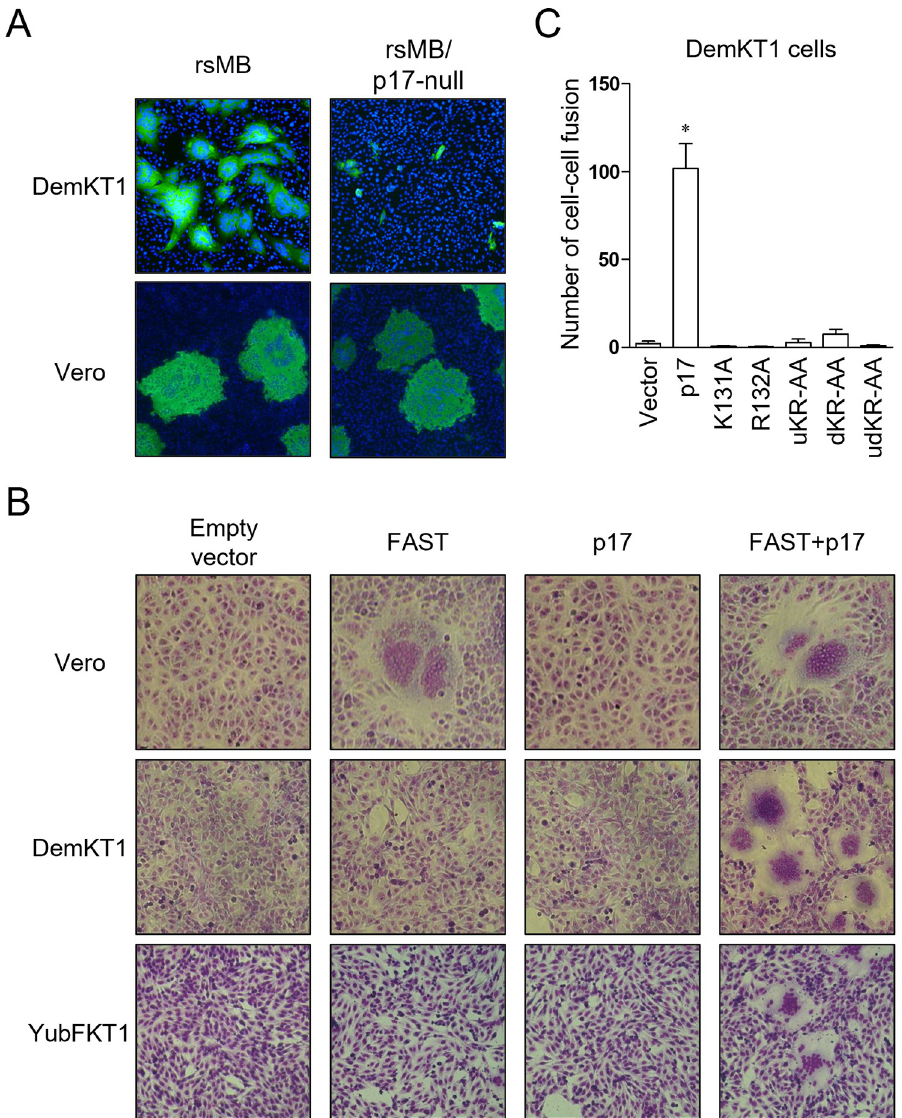
Fig 7. Cell–cell fusion activity of FAST is enhanced in the presence of p17 in bat cells. (A) Immunostaining of DemKT1 and Vero cells infected with rsMB or rsMB/p17-null at an MOI of 0.1 PFU/cell. Infected cells were stained using DAPI (blue) and an anti-NBV σ C antibody (green) to observe cell–cell fusion. (B) Observation of cell–cell fusion activity. NBV p17 and/or FAST expression plasmids were transfected into Vero (monkey), DemKT1 (bat), and YubFKT1 (bat) cells. Transfected cells were fixed and stained with Giemsa’s Stain Solution. (C) The number of cell– cell fusions in DemKT1 cells expressing NBV FAST and wild-type or mutant p17s. Results are expressed as the mean of total samples. Error bars indicate standard deviations (n = 5). Significant differences compared to the vector control are indicated by asterisks. � p < 0.05 (Dunnett’s test).